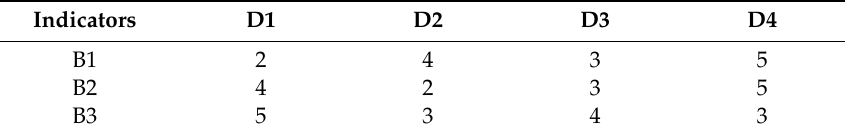
Table 6. Initial decision-making matrix.